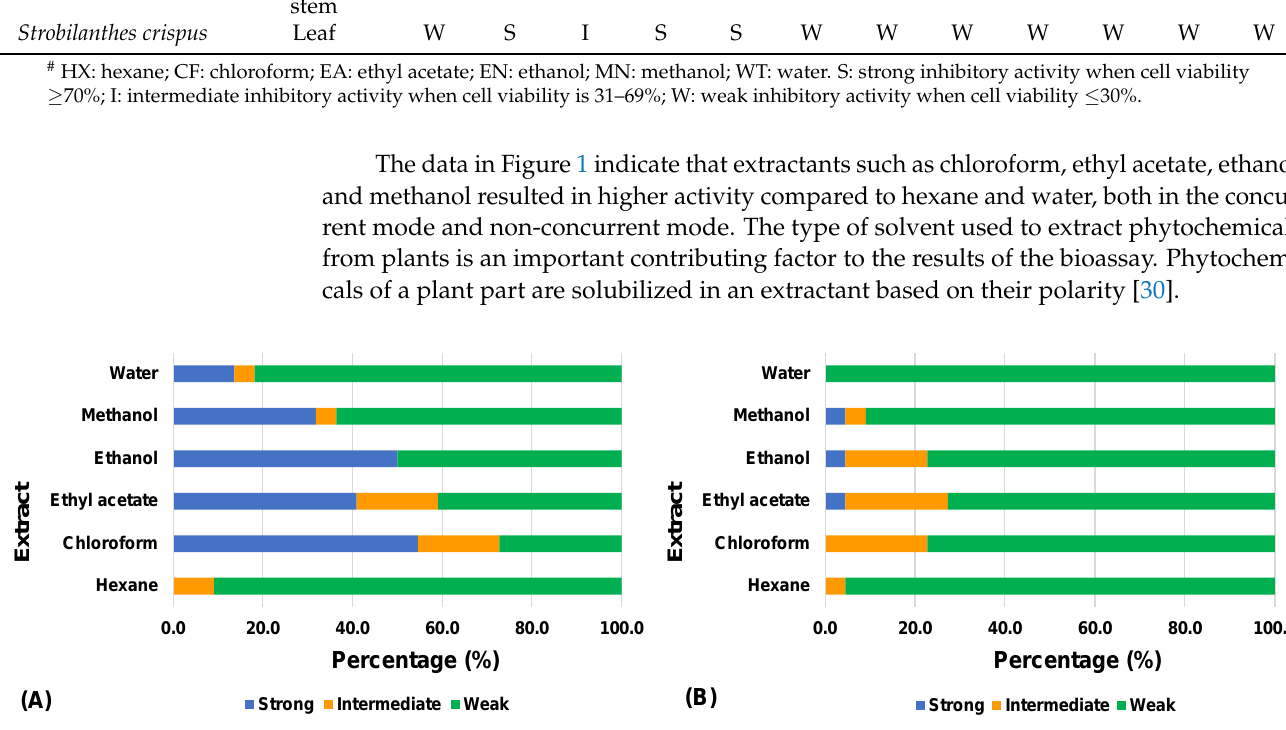
Figure 1. Classification of medicinal plant extracts according to their cytopathic effect inhibitory activity against chikungunya virus in ( A ) concurrent mode and ( B ) non-concurrent mode. The number of extracts for each extractant is 22. The inhibitory activity is measured based on the percentage of viable cells protected by an extract from the cytopathic effect caused by the virus. Strong: cell viability ≥70%; intermediate: cell viability 31–69%; weak: cell viability ≤30%.